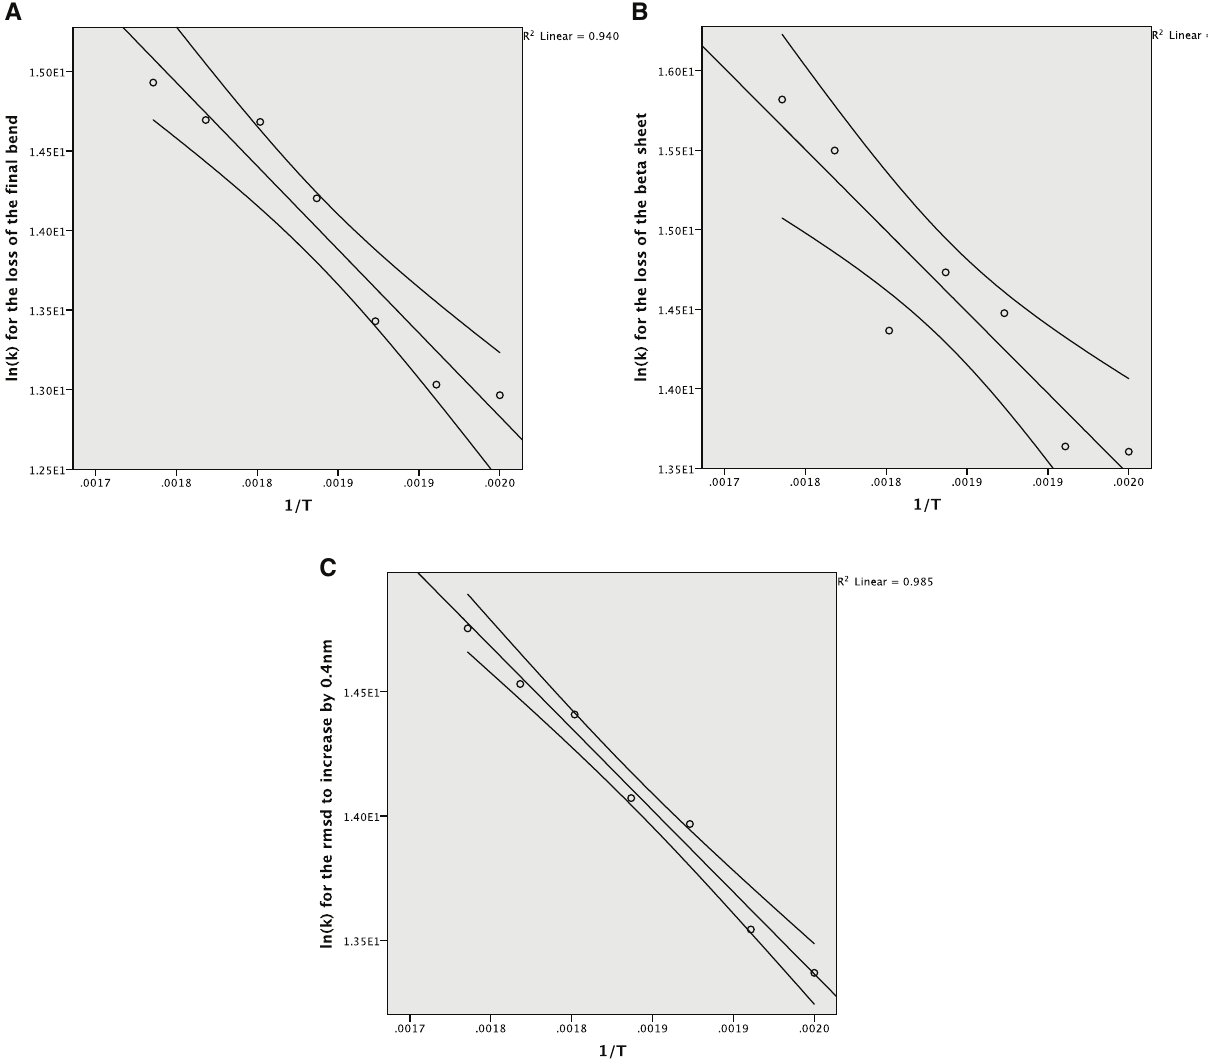
Figure 3. A : The Arrhenius plot for the unfolding of the final bend using the averaged data. B : The Arrhenius plot for the unfolding of the beta sheet using the averaged data. C : The Arrhenius plot for the increase of the RMSD by 0.4nm from the crystal structure using the averaged